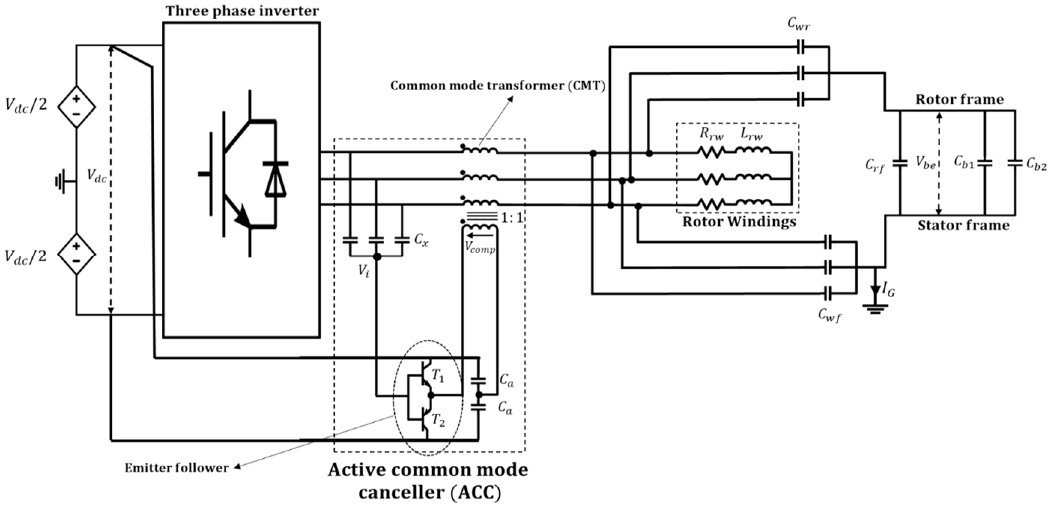
Figure 2. Physical construction of the doubly-fed induction generator showing different stray capacitances.